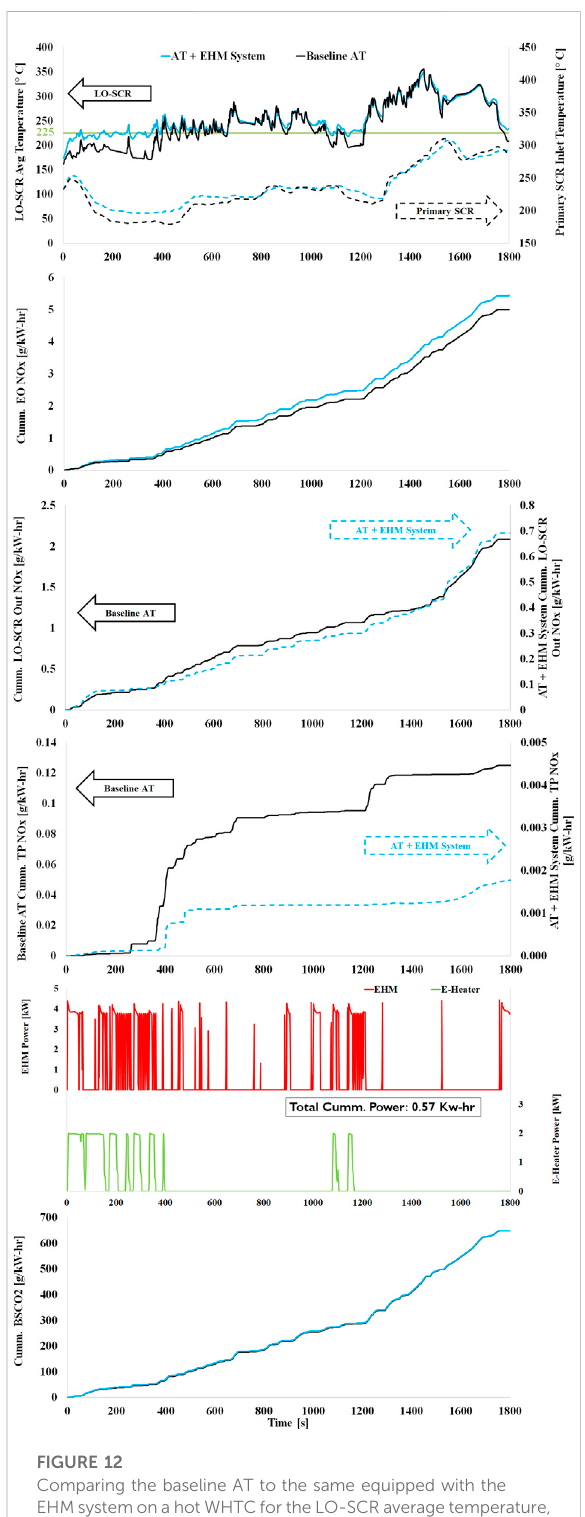
FIGURE 12 Comparing the baseline AT to the same equipped with